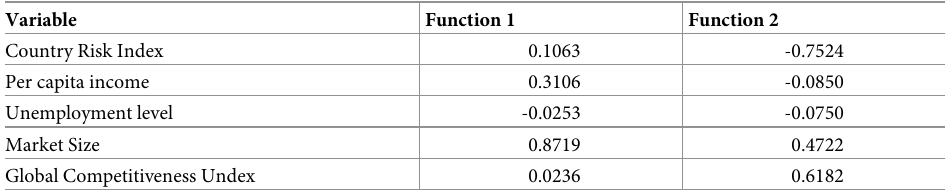
Table 8. Correlations between independent and canonical variables.